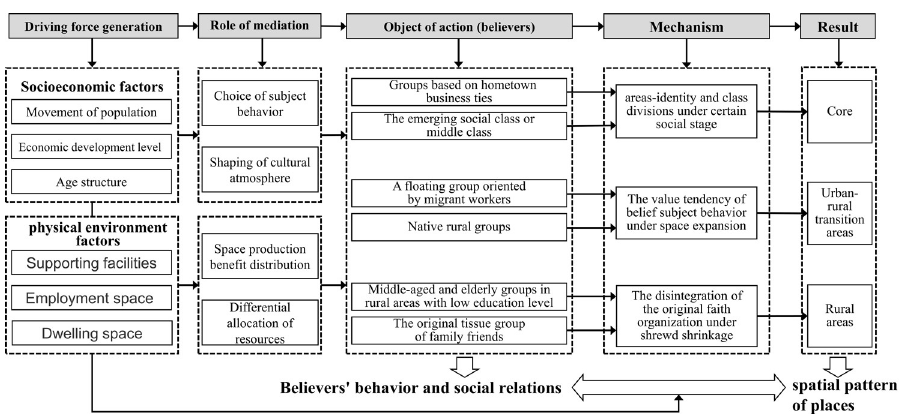
Fig 6. The process of influencing factors in the spatial differentiation pattern. The whole process includes five parts: first, the driving force includes socioeconomic factors and physical environment factors. Secondly, under the action of the above two kinds of factors, two mediations are created respectively: believers’ behavioral choices and Spatial resource allocation. Thirdly, three types of typical object are formed. Fourth, different categories of object follow different mechanisms. Finally, the characteristics of circle layer differentiation are formed in